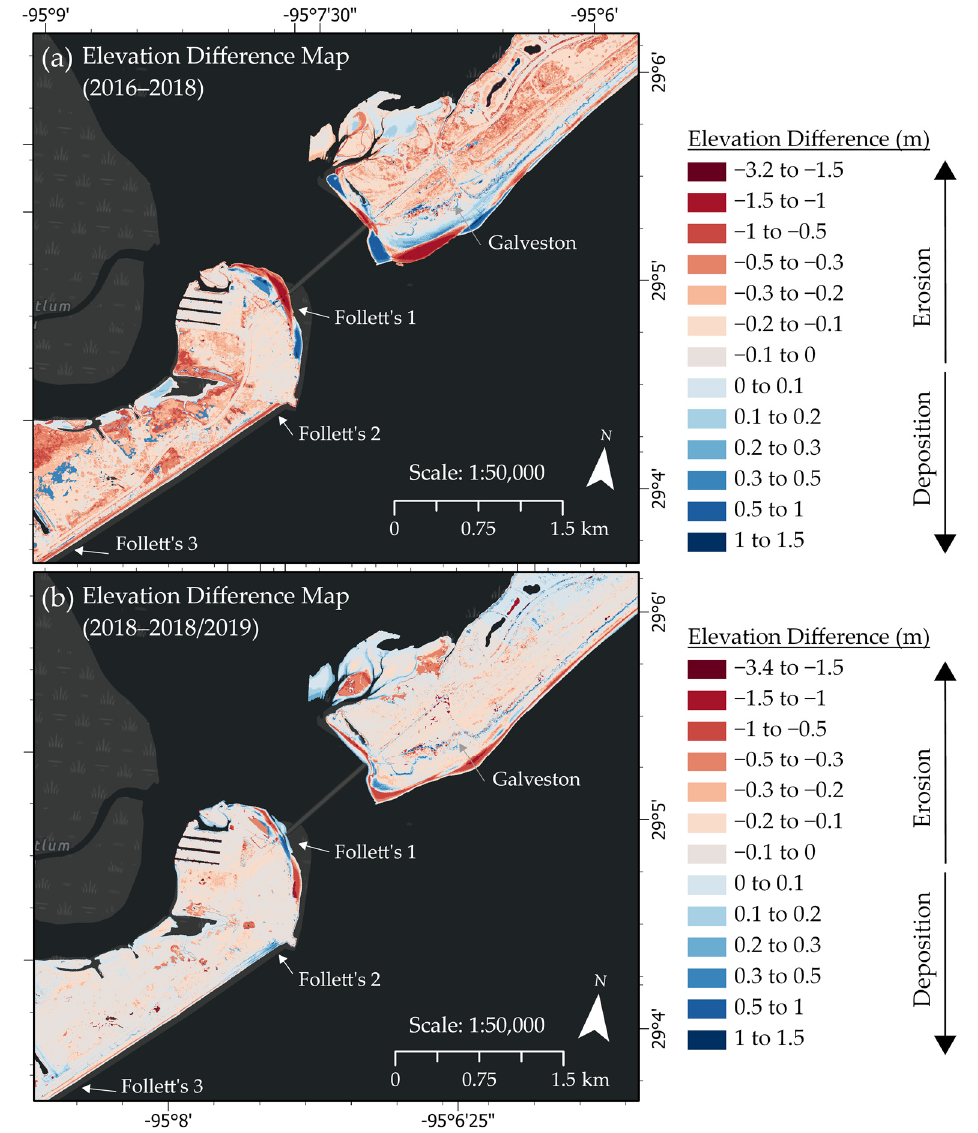
Figure 13. Comparison of elevation difference maps. ( a ) A difference map generated by comparing 2016 and 2018 bare ground data sets; ( b ) A difference map was generated by comparing 2018 and 2018/2019 data (Table 1).